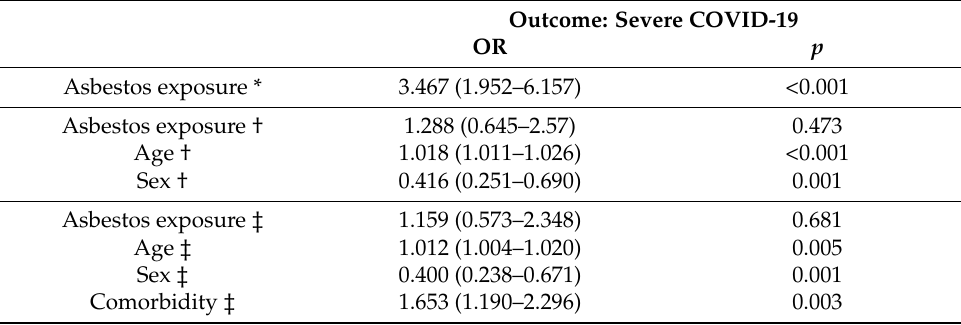
Table 4. Logistic regression